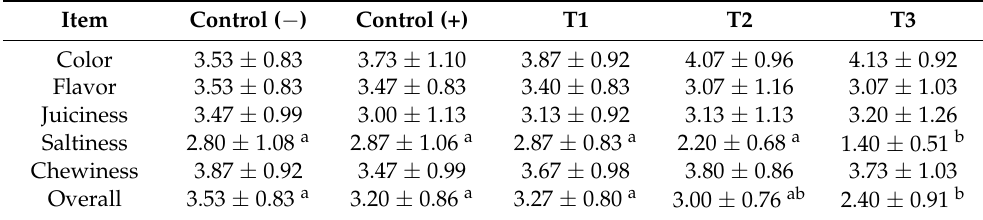
Table 5. Sensory evaluation of pork patties with fermented soy sauce.